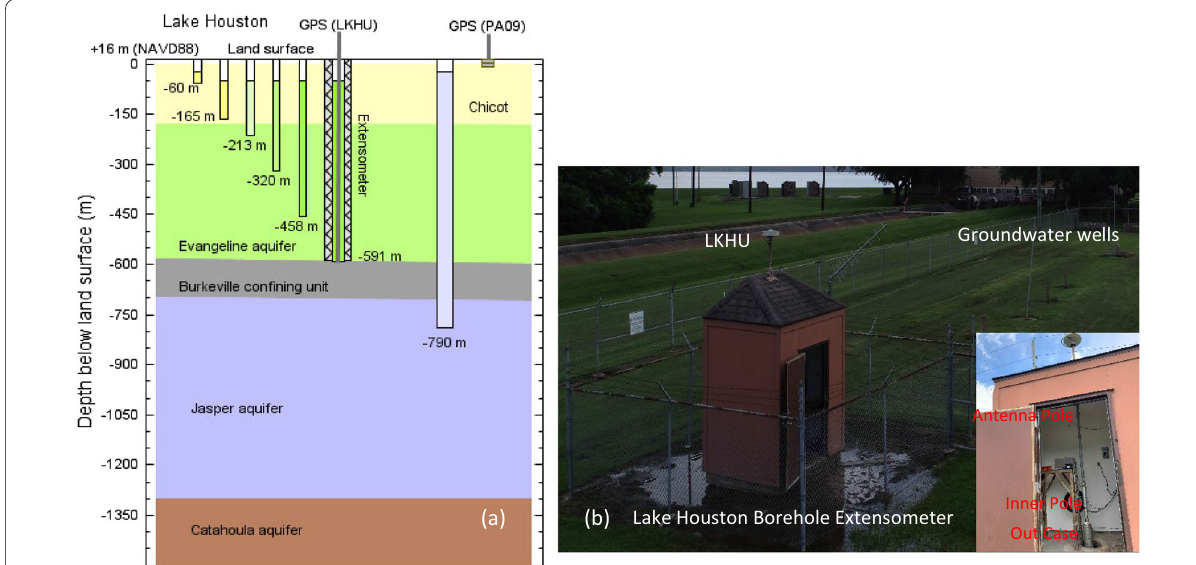
Fig. 10 a A sketch showing the depths of groundwater wells at the Lake Houston site; b a site photo showing extensometer, GPS, and groundwater wells at the Lake Houston site. The GPS antenna (TXCN) is mounted on the top of the inner pole of the extensometer, which is anchored at the top of the Burkeville confining unit, 591 m below the land